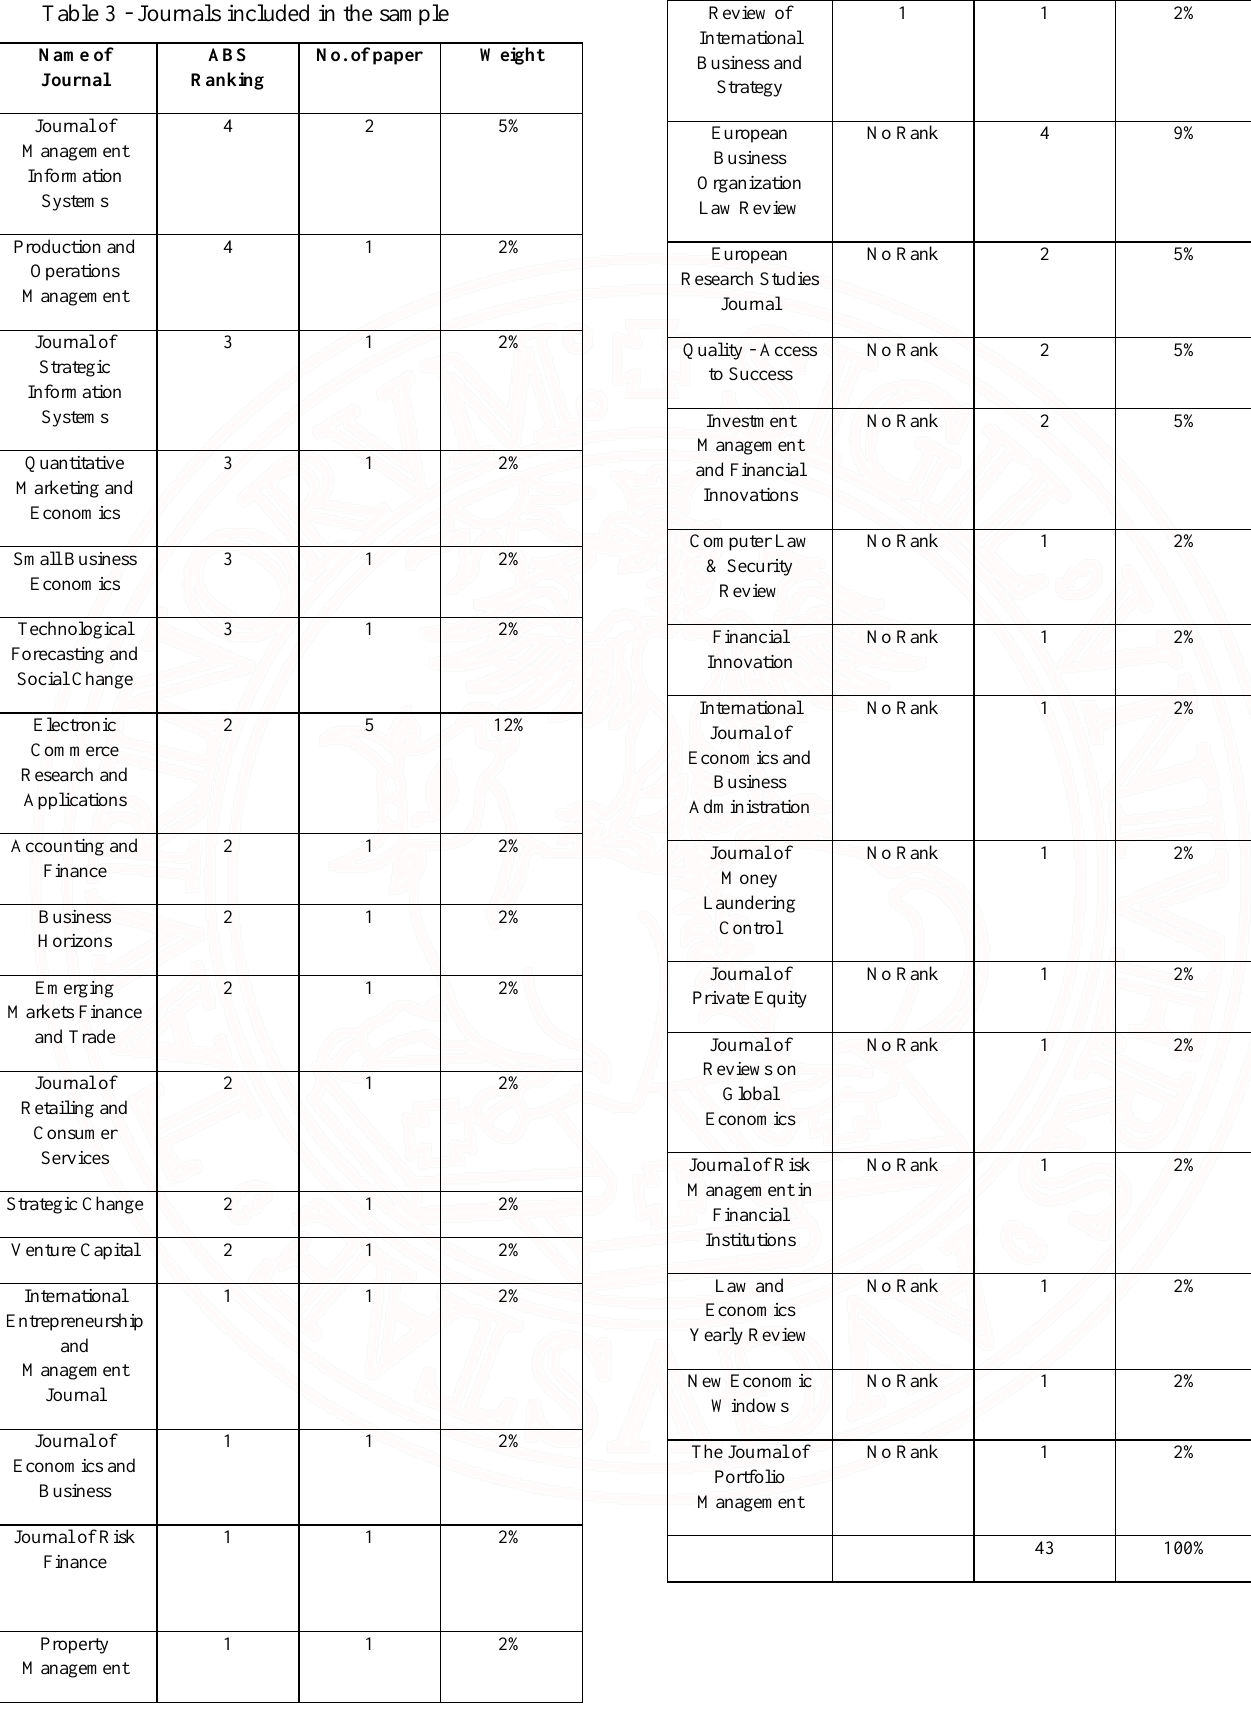
Table 3 - Journals included in the